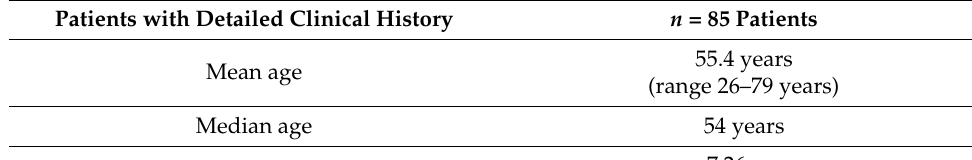
Table 1. Clinical characteristics of the 85 patients with thymic carcinoma.